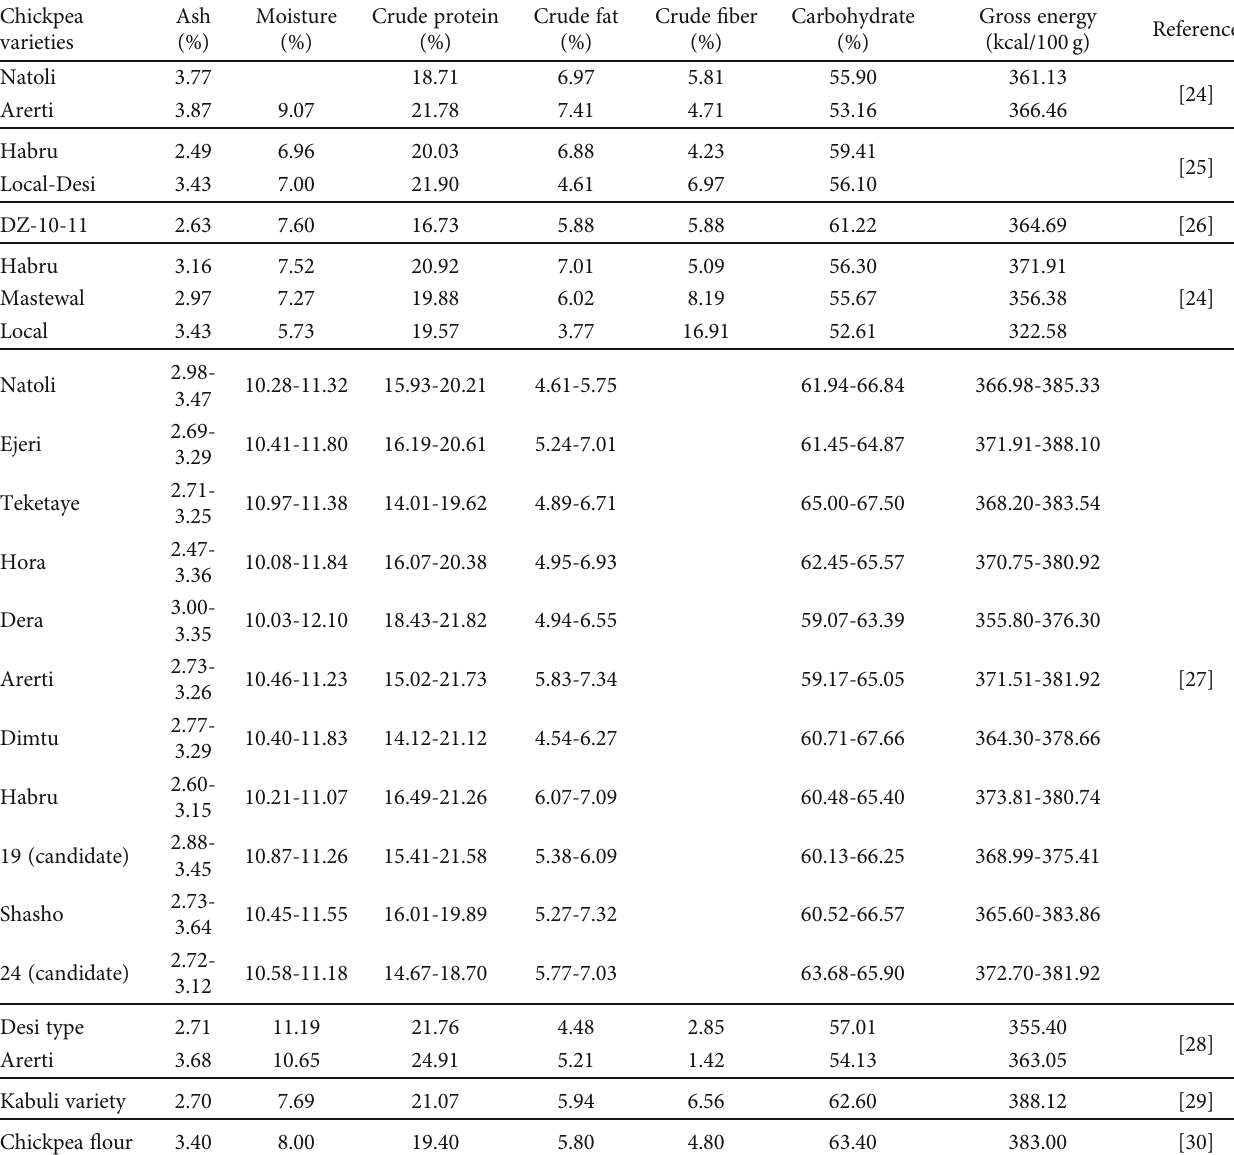
Table 3: Chemical composition of some of Ethiopian raw whole chickpea